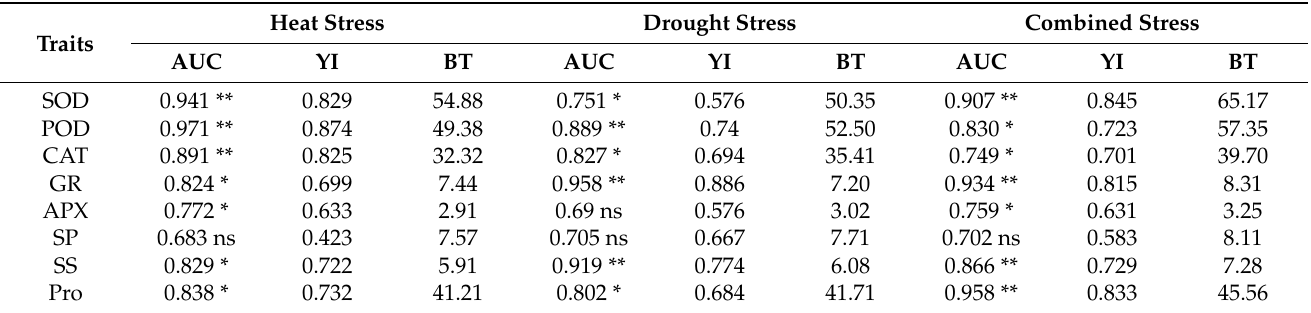
Table 2. The results of ROC in diagnosing heat, drought, and combined